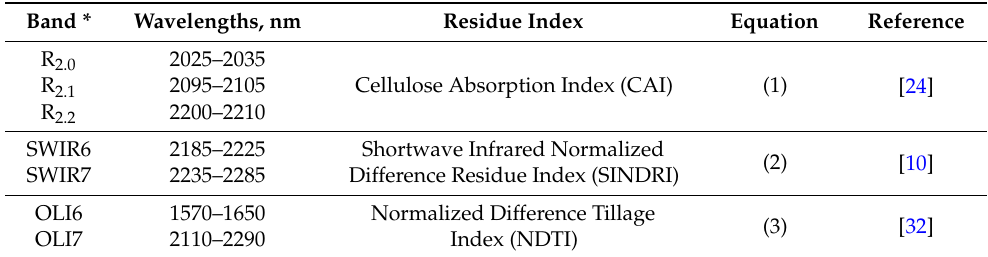
Table 2. Spectral bands used for the crop residue cover indices.